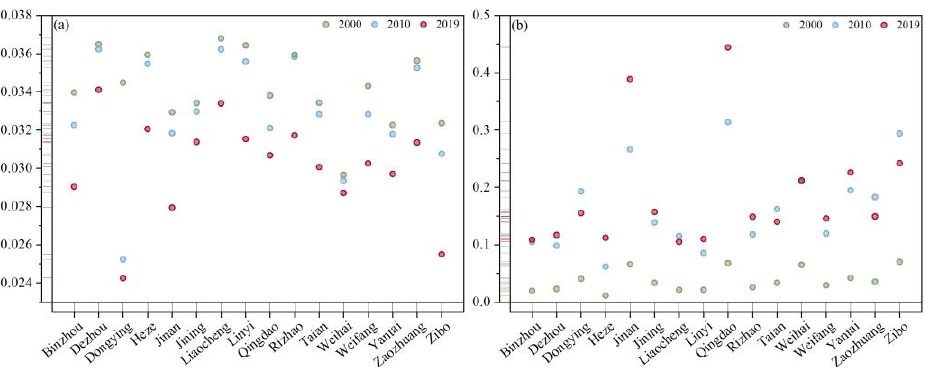
Figure 7. Spatial and temporal variation in land-average carbon emissions from major carbon sources in Shandong Peninsula urban agglomeration from 2000 to 2019 (unit: kg/km 2 ). ( a ) Land-average carbon emissions from cropland; ( b ) land-average carbon emissions from construction land.